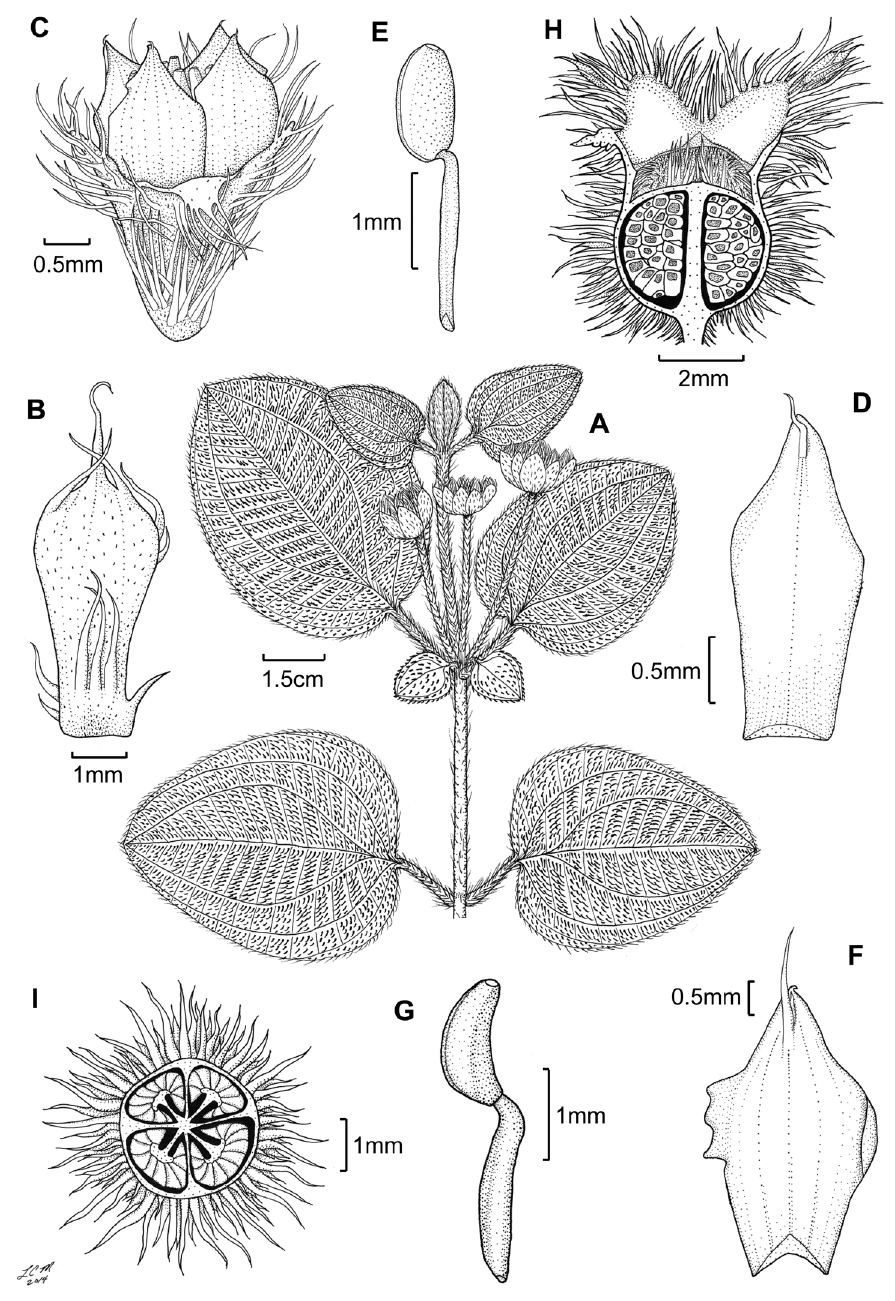
Figure 22. Miconia pedunculata ( A–E ) and M. limoides ( F–H ). A habit of M. pedunculata ( Pimentel 806 ) B bracteole ( Zanoni 40212 ) C flower ( Judd 6633 ) D petal abaxial surface ( Zanoni 28291 ) E stamen ( Zanoni 28291 ) F petal abaxial surface of M. limoides ( Zanoni 18900 ) G stamen ( Zanoni 18900 ) H fruit longitudinal section ( Ekman 9579